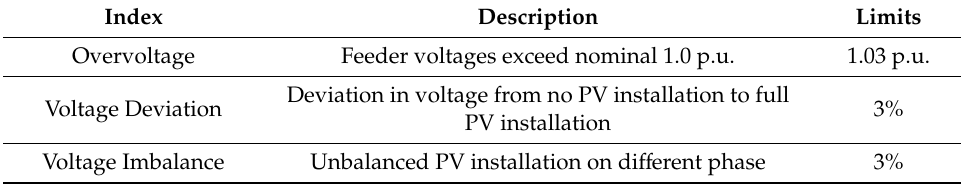
Table 1. Voltage performance indices and limits for the analysis in study.